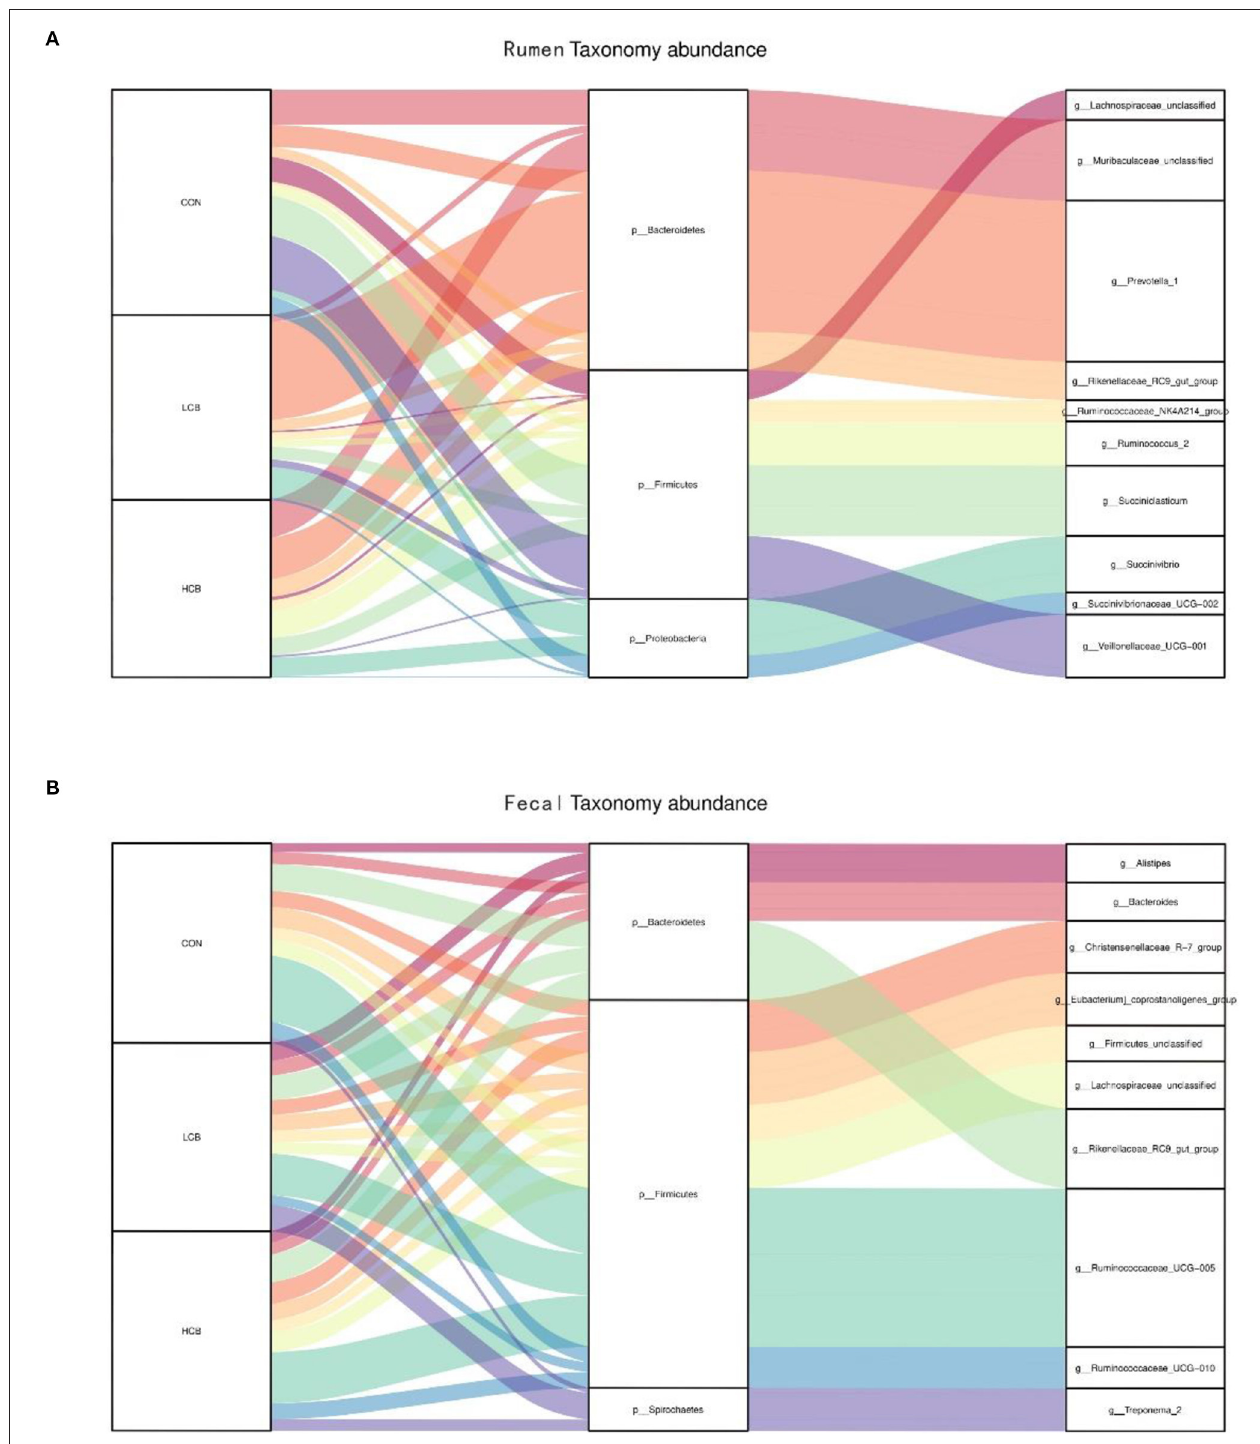
FIGURE 5 | Sankey plot displays a comparison of microbial relative abundance (%) at genus level among main effects of treatments in rumen (A) and fecal (B) of fattening goats. The label CON denotes without prebiotics, the label LCB denotes low-dose C. butyricum, and the label HCB denotes high-dose C. butyricum for each sample. CON: 0 CFU C. butyricum per kilogram feed, LCB: 2.0 × 10 8 CFU C. butyricum per kilogram feed, HCB: 1.0 × 10 9 CFU C. butyricum per kilogram